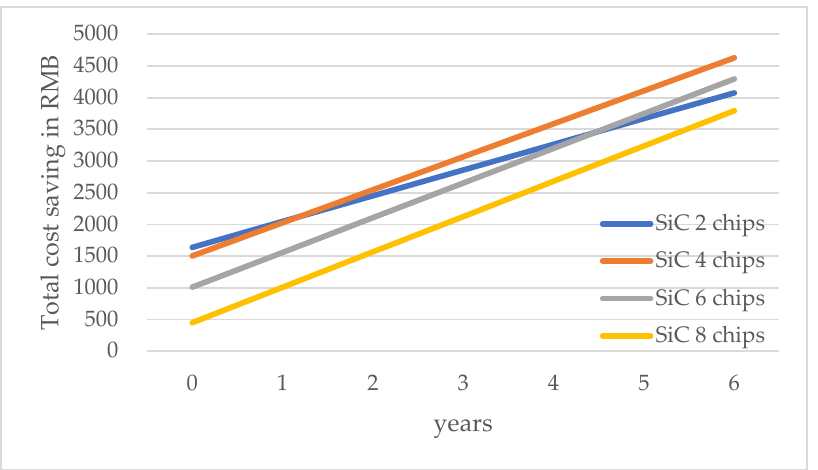
Figure 8. Impact of SiC chip paralleling number on the total cost saving (compared to IGBT module).